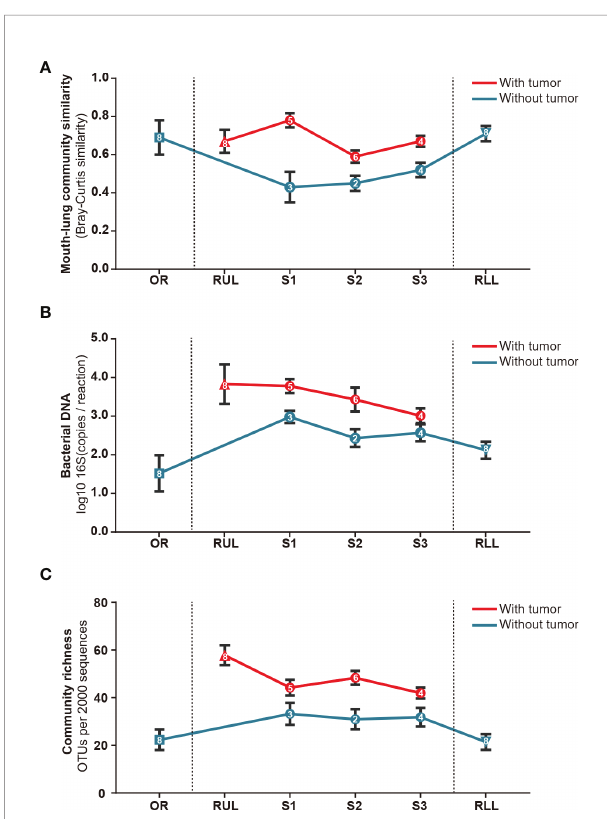
FIGURE 4 | Bacterial topography in sMPLC. To clarify whether there was mouth – lung bacterial immigration to the RUL or speci fi c colonizing bacteria in the RUL, we quanti fi ed specimens from different sites using mouth – lung community similarity (Bray – Curtis similarity). (A) Bacterial DNA (log10 number of 16S copies per reaction determined by real-time qPCR); (B) community richness (number of OTUs per 2,000 sequences); (C) connecting lines (red: with tumor, blue: without tumor) of bacterial expression levels in specimens from different sites (square: oral cavity, triangle: lung lobe, circle: pulmonary segments) of the respiratory tract exhibiting less evidence of mouth – lung immigration than RUL specimens ( P < 0.001, paired Student ’ s t- test). Indices of mouth – lung immigration in airway PSB samples were nonlinear. Patients with sMPLC showed regional differences in fl ora caused by non-aspiration. Data are mean ± SEM (n = 8). RUL, right upper lobe; RLL, right lower lobe; SEM, standard error of